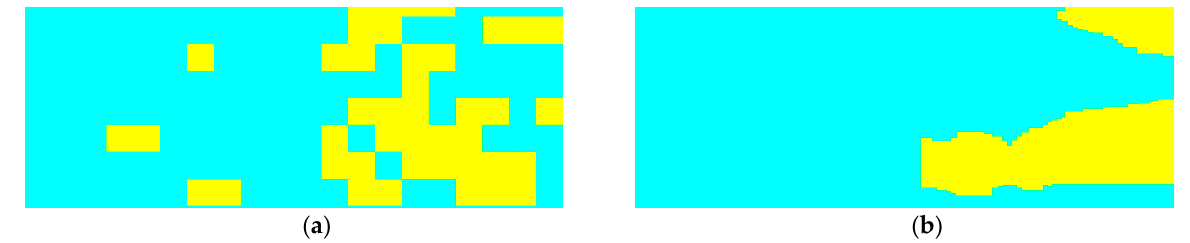
Figure 14. Sand wave detection for example SSS imaging. ( a ) Basic MobileNet with SSS imaging. ( b ) OS-ELM with echo intensity.